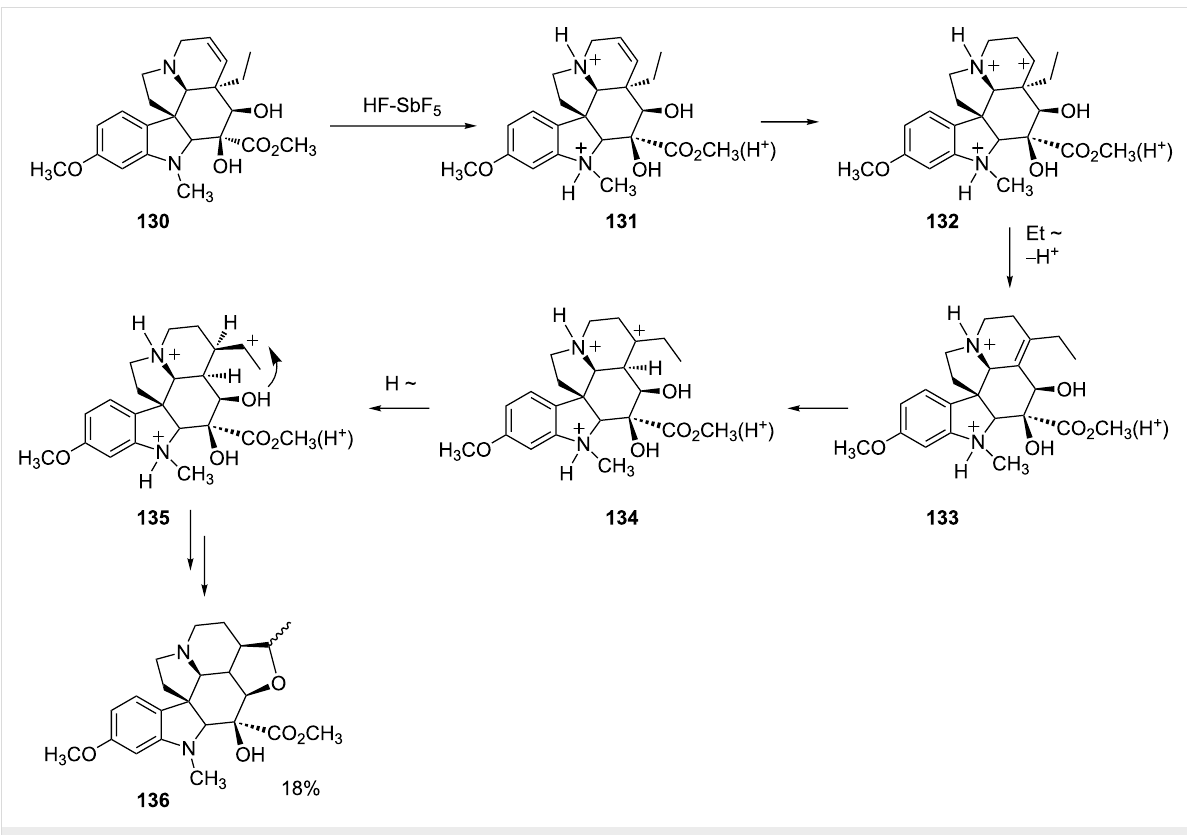
Scheme 26: Superacid-promoted reaction of vindoline derivative 130